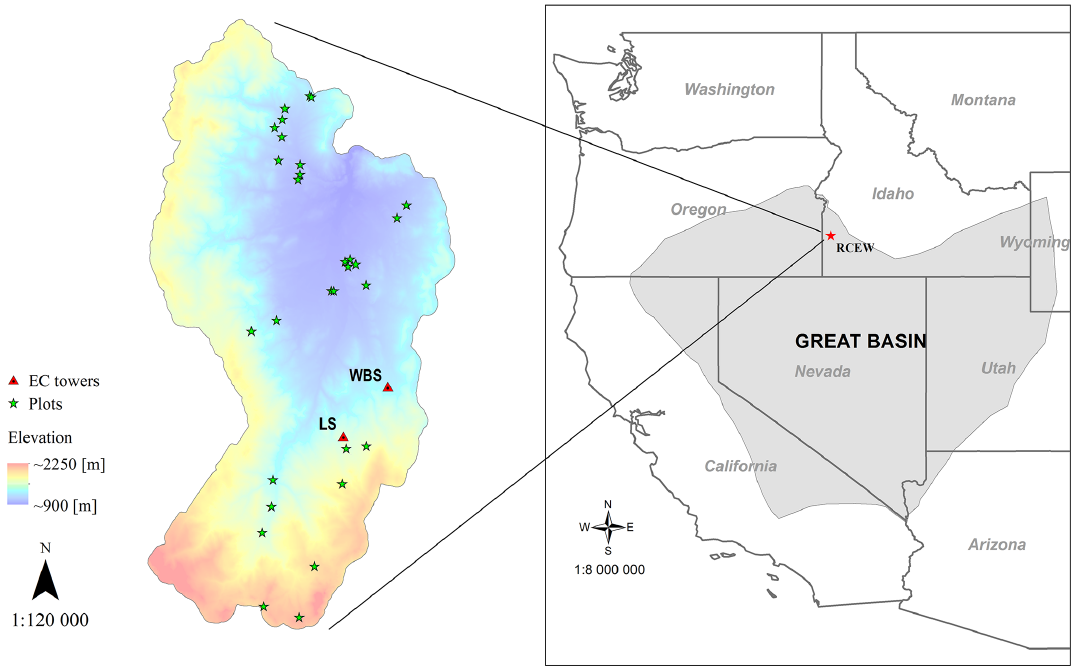
Figure 1. Location of EC flux sites in the RCEW study area: designated as LS (for low sagebrush) and WBS (for Wyoming big sagebrush). Field plots depicted were used to develop the allometric equations. The inset map shows the location of the RCEW study area within the northern Great Basin (LCC, 2018).